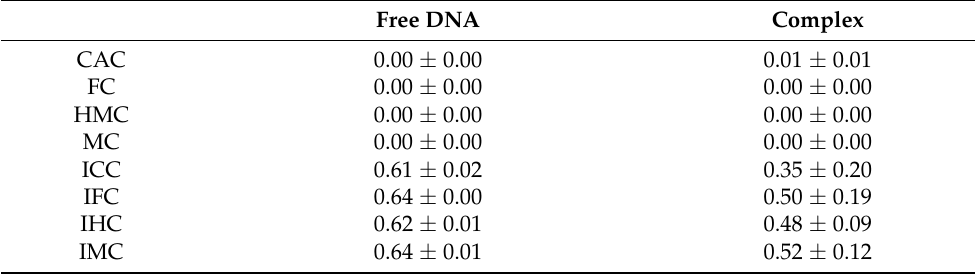
Figure 10. Probabilities of hydrogen bonds between the oxidised methyl-cytosine (XC) and the complementary guanine (G17) in ( a ) free DNA and ( b ) DNA complexed to TDG. Only hydrogen bonds that have a probability of at least 0.5 in at least one of the models are shown. Table 2. Probability of water-mediated hydrogen bonds between the guanine (G17) and the oxidised methyl-cytosine